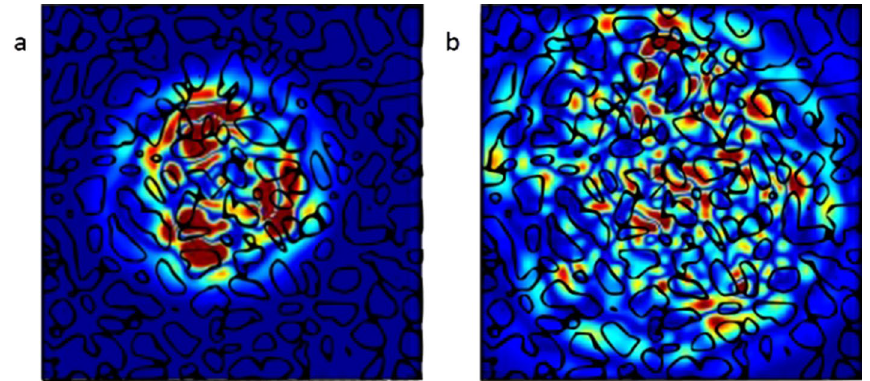
Figure 5. Pulse propagation in NwN morphology setting up whispering gallery type modes for a short duration (top view, snapshots at two instants)—single dipole source used. Time instant of ( a ) precedes that of ( b ). Red is highest field intensity and blue is lowest. See Supplementary Movie S1 for full animation of the simulation with modelled material